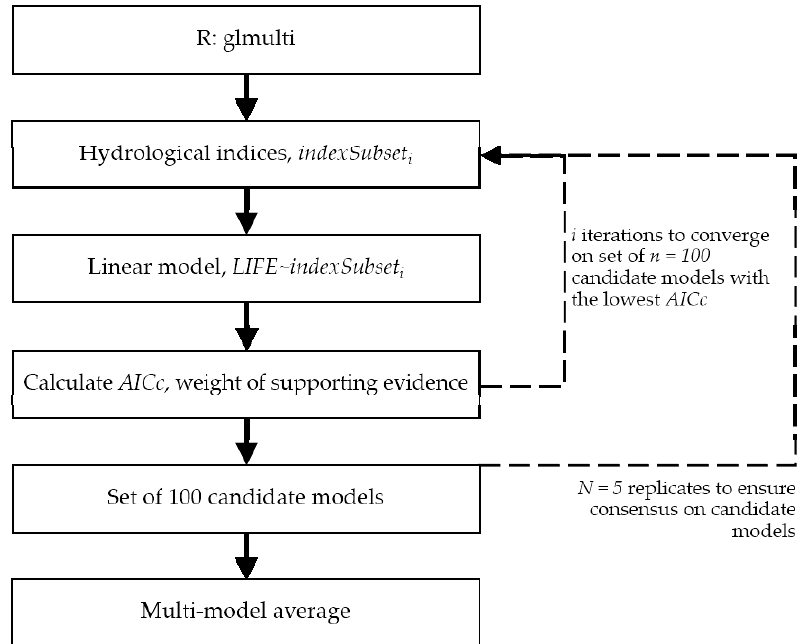
Figure 2. Stages of the hydroecological modelling following an information theory approach [ 38 ].